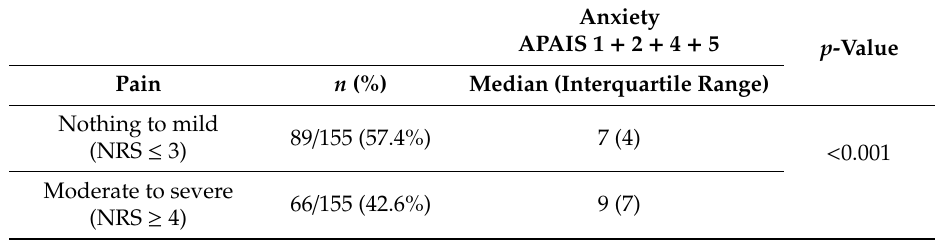
Table 5 reflects the anxiety scores according to the referred postsurgical pain groups. Table 5. Postoperative pain after 24 h according to the APAIS scores. Anxiety was dichotomized according to the cuto ff point established by the authors of the original version of APAIS to determine clinical anxiety ( ≥ 11)